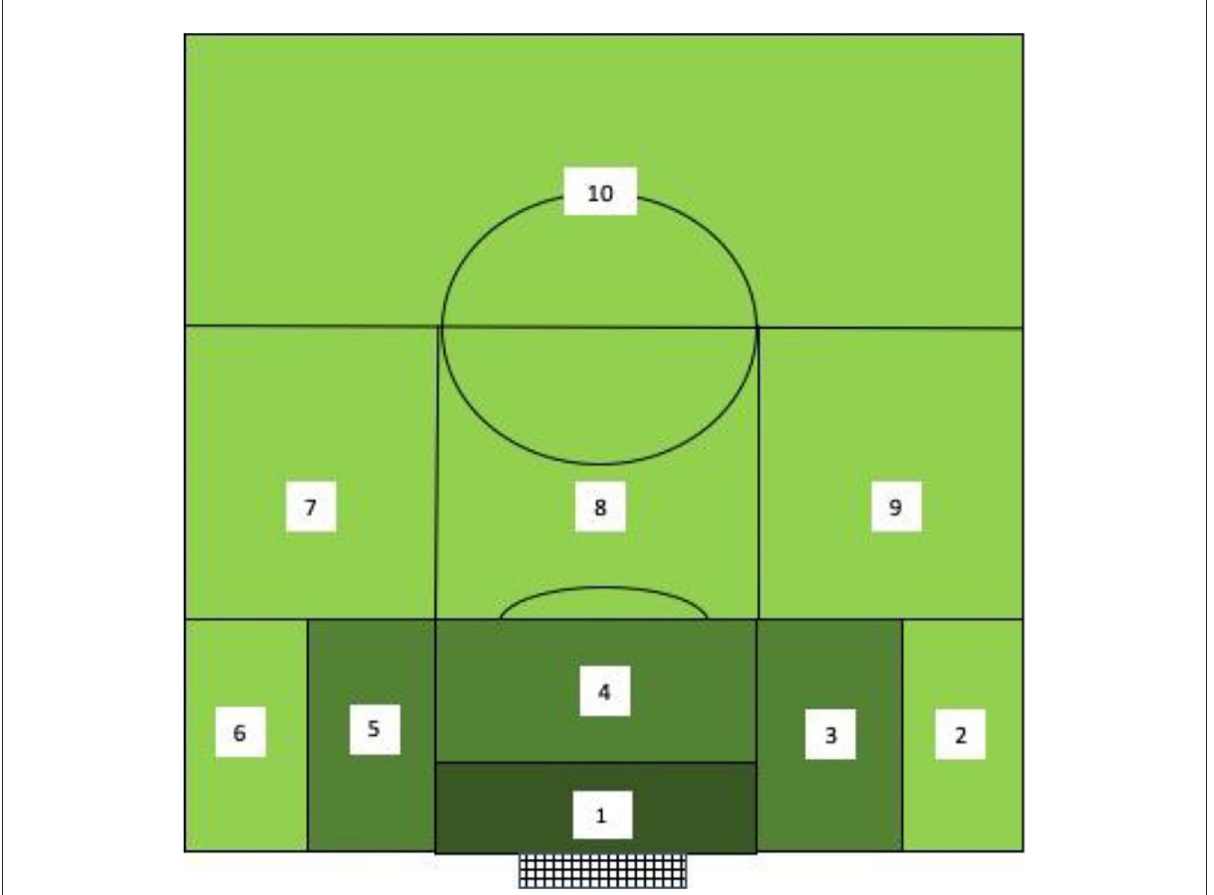
FIGURE1 Campogram for defensive technical-tactical actions (adapted from Lapresa Ajamil et al.,